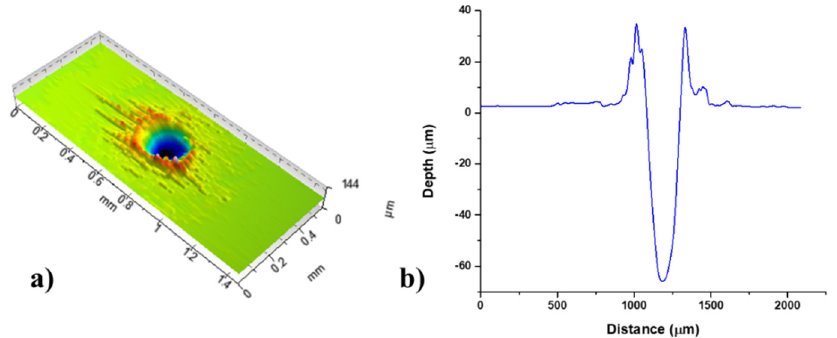
Figure 6. Nimonic 263 area modified by F = 15.1 J cm − 2 , pulse count 1000 in the argon-rich atmos- phere: ( a ) 3D map, ( b ) 2D profile.